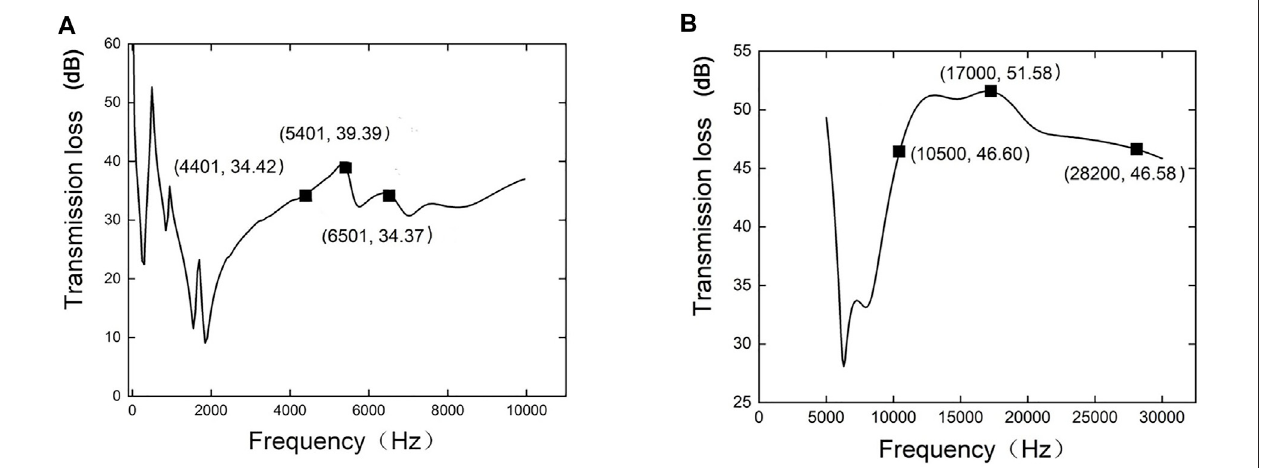
FIGURE 7 | Performance curves for sound insulation for two different magnetic fi eld strength: (A) 20 kA/m and (B) 890 kA/m.